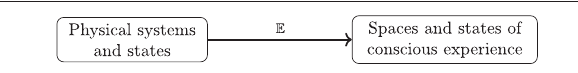
FIGURE 1 | An Integrated Information Theory speci fi es for every system inaparticularstateitsconsciousexperience,describedformallyasanelement ofanexperiencespace.Inourformalization,thisisamap Sys → E Exp fromthe system class Sys into a class Exp of experience spaces, which, fi rst, sends each system S to its space of possible experiences E ( S ) , and, second, sendseachstate s ∈ St ( S ) totheactualexperiencethesystemishavingwhen in that space, St ( S ) → E ( S ) , s 1 E ( S , s ) . The de fi nition of this map in terms of axiomatic descriptions of physical systems, experience spaces and further structure used in classical IIT is given in the fi rst half of this